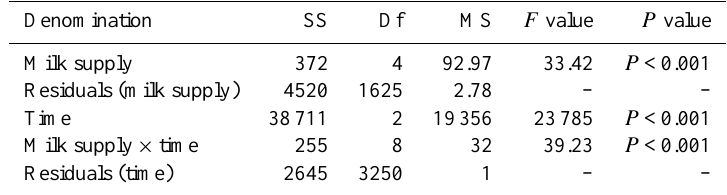
SS: sum of square, Df: degree of freedom, MS: mean